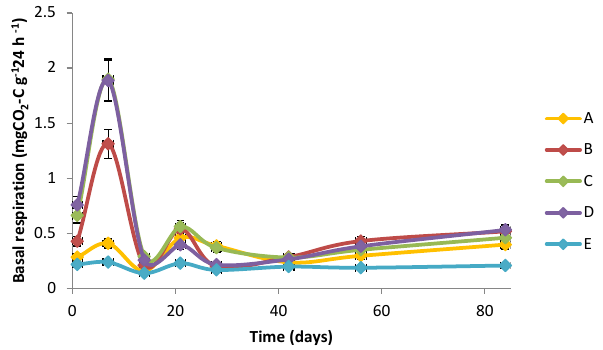
Figure 4. Changes of microbial respiration in remediated soil (A, B, C, D, E – as in Fig.